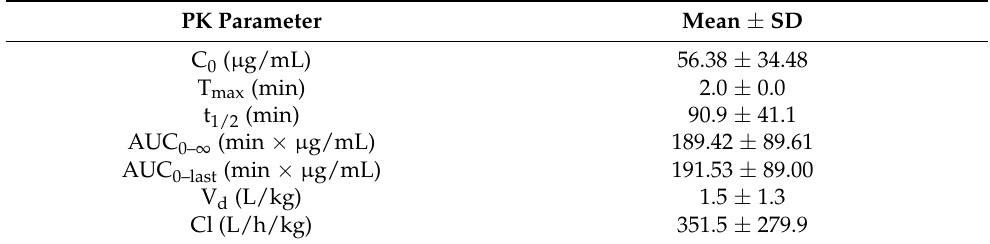
Table 6. Summary of ICG PK parameters after IV (0.39 mg/kg) administration (mean ± SD, n =